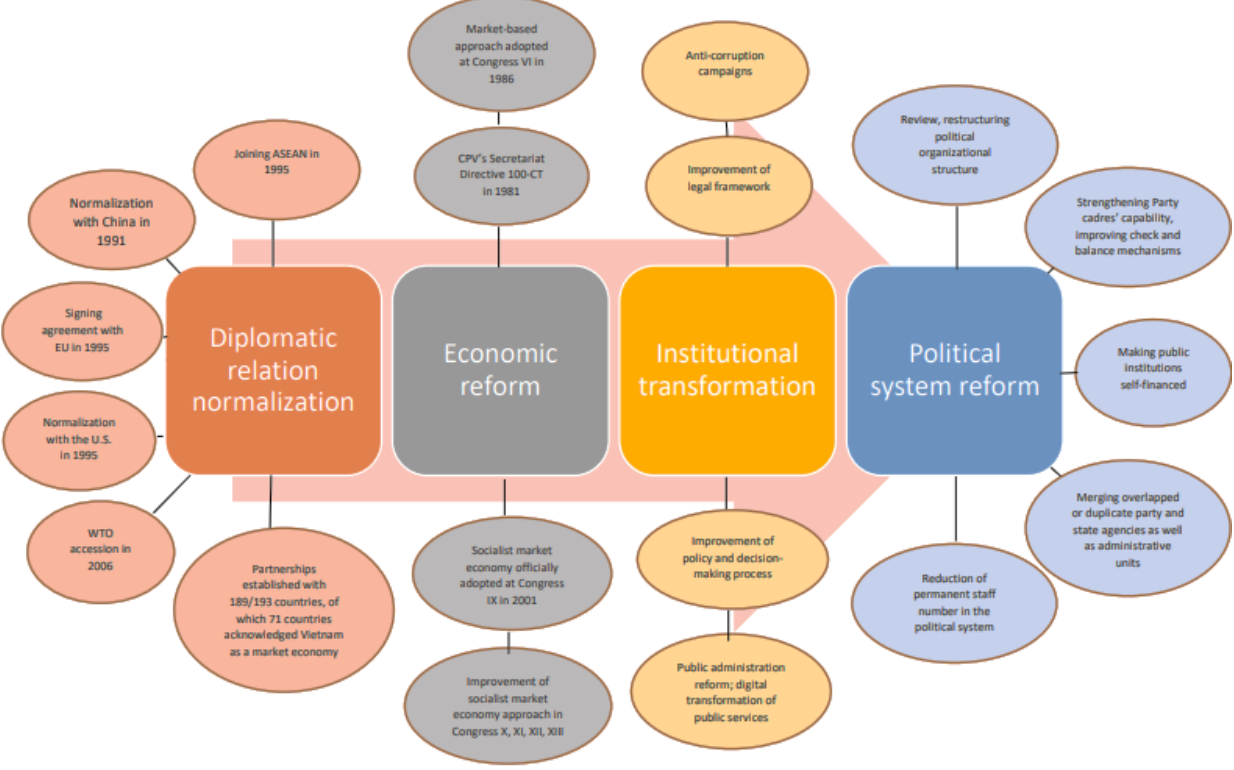
Figure 1. Flowchart of the research